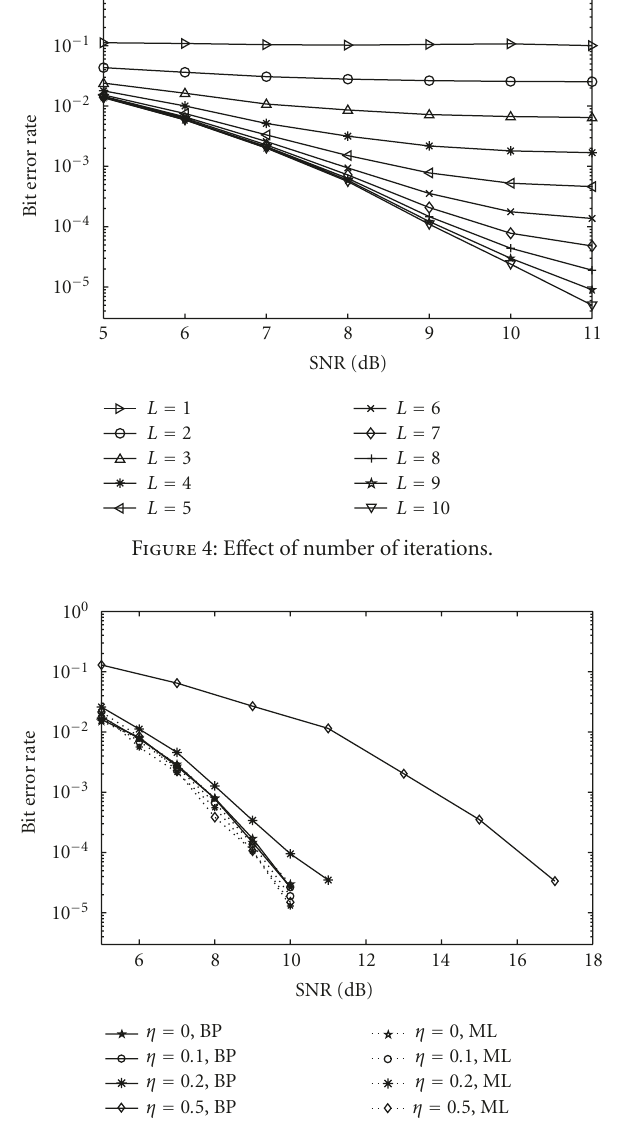
Figure 5: Performance over 2PR4 channel.